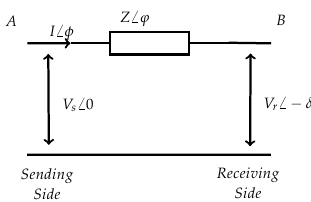
Figure 11. Power flow from sending to receiving